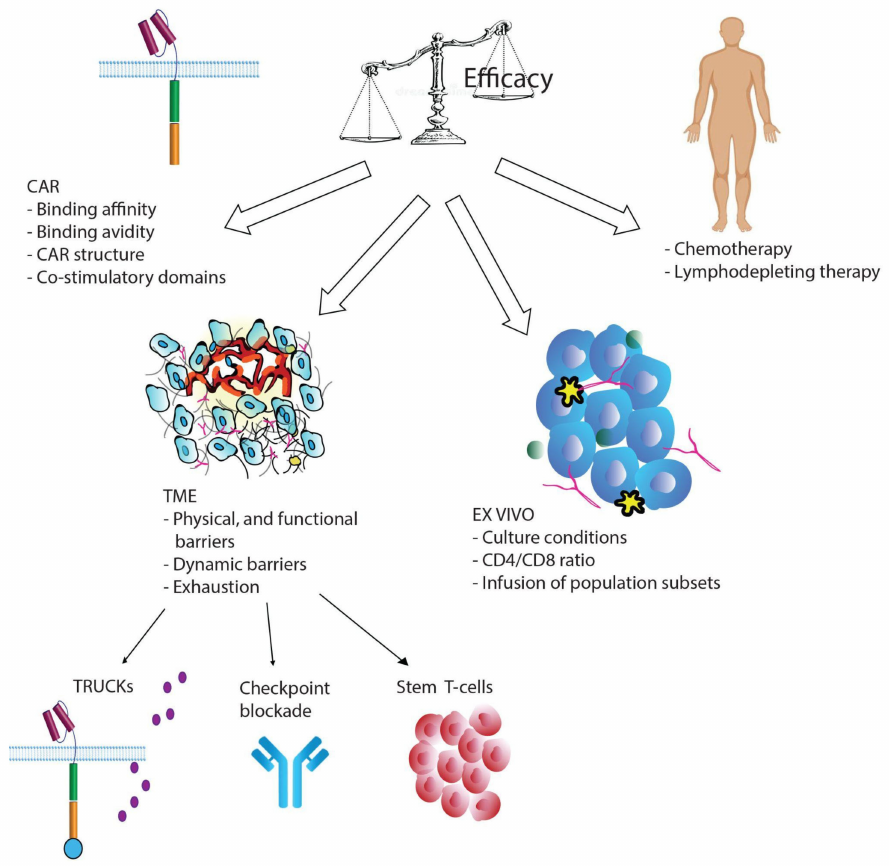
Figure 1. A schematic of determinants affecting the efficacy of CAR T-cell therapy and possible solutions to the issue of T-cell